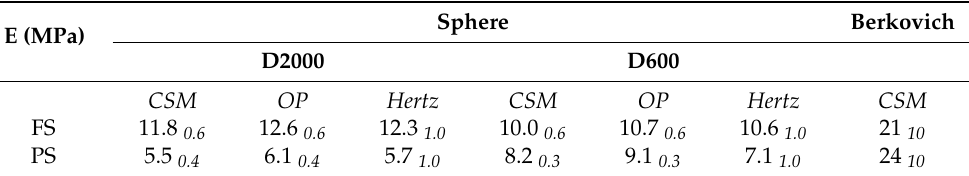
Figure 3. Contact stress–strain curves on FS (in green) and PS compacts (in blue) measured with a 2000-µm diameter sphere. Triangles illustrate the difference in slope between FS and PS compacts. Table 2. Average values and standard deviations of elastic modulus of FS and PS compacts determined from indentation tests with different tips and using different calculation methods. Poisson’s ratio is considered equal to 0.2. CSM: continuous stiffness measurement, OP: Oliver–Pharr. Numbers in italic stand for the standard